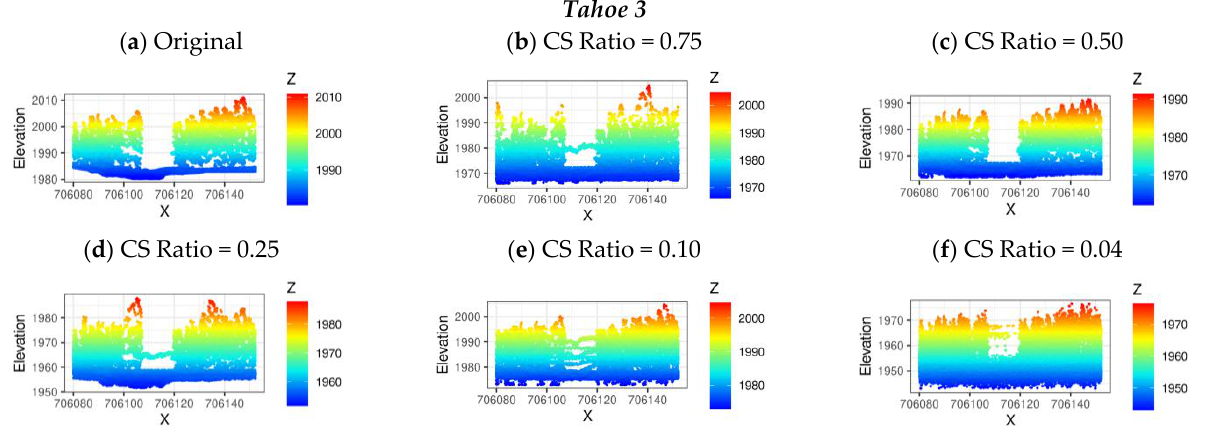
Figure 8. Illustration showing the reconstructed point clouds using the proposed ADCoSNet for different CS ratios for the selected Tahoe 1, Tahoe 2 and Tahoe 3 test sites. ( a ) Original; ( b ) CS Ratio = 0.75; ( c ) CS Ratio = 0.50; ( d ) CS Ratio = 0.25; ( e ) CS Ratio = 0.10; ( f ) CS Ratio = 0.04.